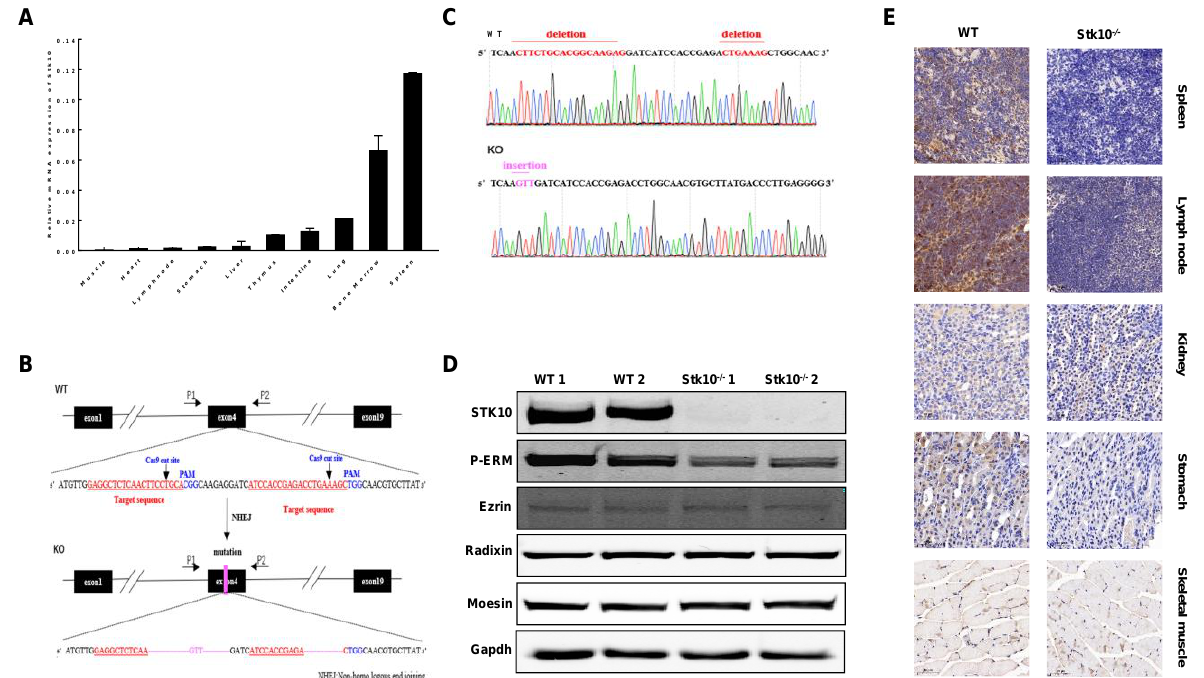
Figure 2. Construction of Stk10 knockout mice. ( A ) Tissue expression profile of Stk10 in C57BL/6J mice, with β -actin as an internal reference and expressed as mean ± standard deviation ( n = 3/group). ( B ) Mouse Stk10 knockout strategy; gRNA is the target sequence; NHEJ: non-homologous terminal connection. Wild type sequence is in black; Target sequence is in red; PAM sequence is in blue; Purple represents mutatant part in exon 4. ( C ) DNA sequencing map of Stk10 knockout mice, showing a 22 bp deletion. Wild type sequence is in black; Deletion sequence is in red; Insertion sequence is in purple. ( D ) Stk10 knockout mice were verified by Western blotting (WB) to have complete deletion of Stk10 protein and reduced phosphorylation levels of ERM proteins. ( E ) Expression levels of Stk10 in 5 tissues in Stk10 knockout and WT C57BL/6J mice were detected by immunohistochemical staining. Scale bars, 50 μm.